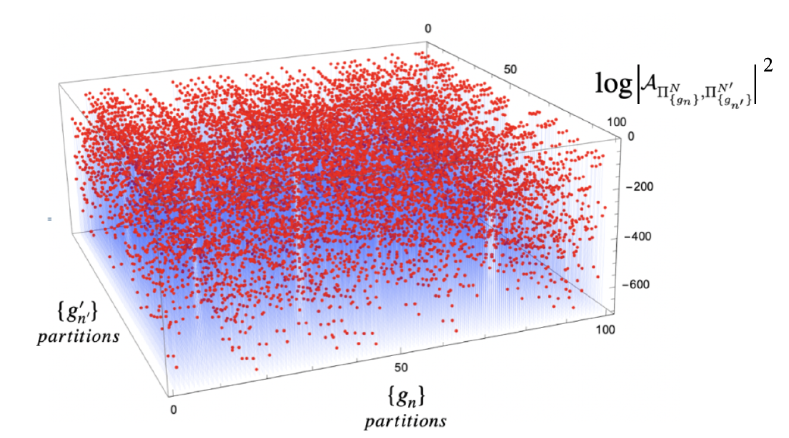
Figure 9 . Microstates population of the decay rate in logarithmic scale for 100 random partitions { g n } of N = 100 and 100 random partitions { g 0 decay rate.